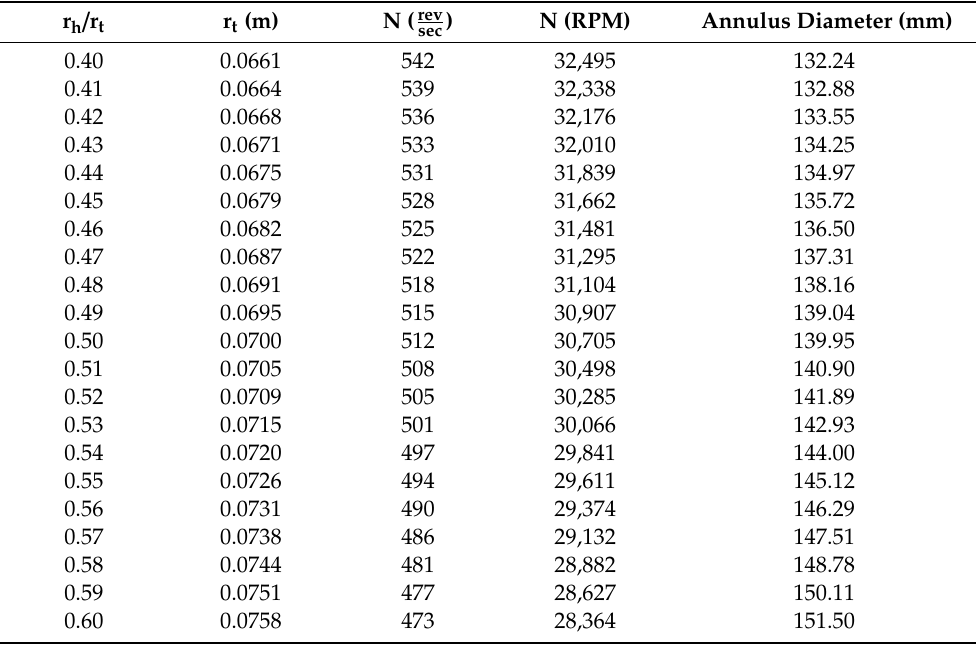
Table 5. Variations of the hub-tip ratio with the spool